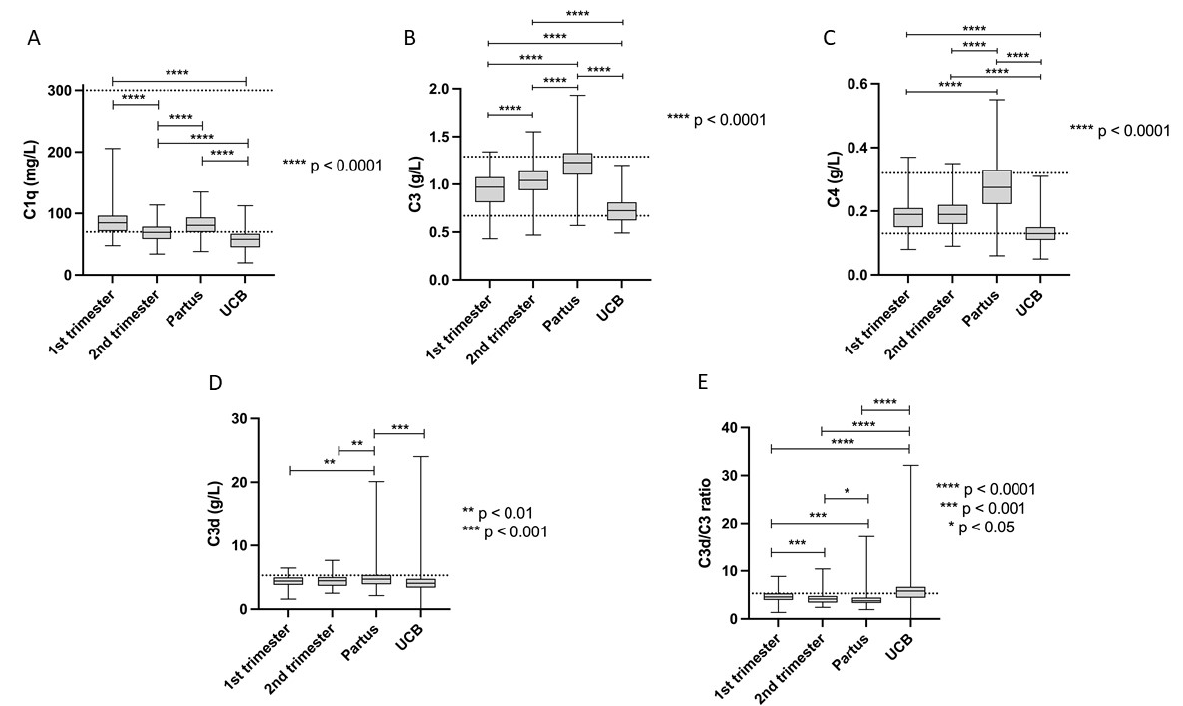
Figure 1. ( A – E ) Complement protein levels in maternal plasma during different stages of pregnancy and in umbilical cord blood (UCB). Dotted lines indicate reference limits used in clinical routine. Boxes show the 25th to 75th percentile, with median values marked inside. The provided p values are Bonferroni-adjusted. Table 2. Complement protein levels in maternal plasma and umbilical cord blood.